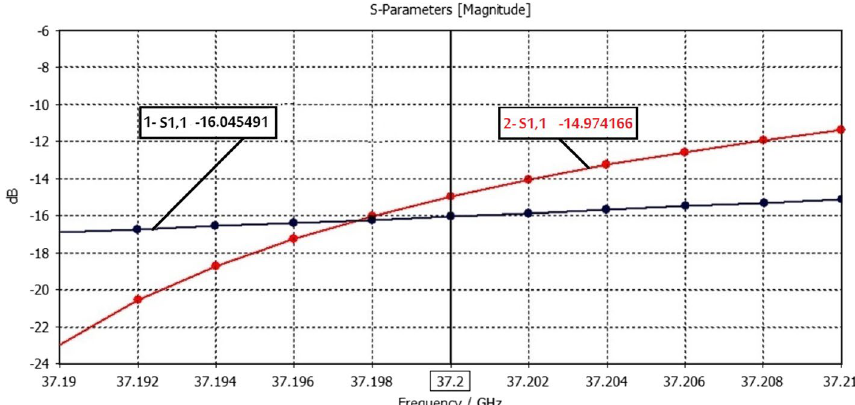
Fig. 14 Comparison of the S11 at the same frequency F = 37.2 GHz for antenna with identical and non-identical irregularities